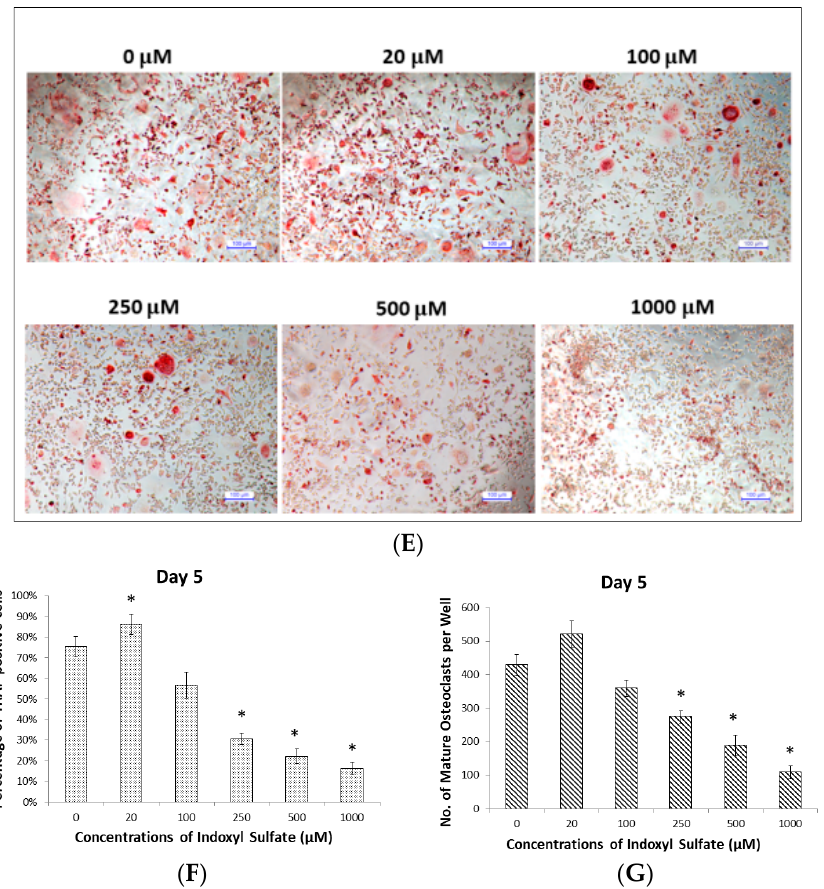
Figure 1. Dose- and time-dependent effects of indoxyl sulfate (IS) on osteoclast differentiation. Raw 264.7 cells with 50 ng/mL of sRANKL were cultured in IS at 0, 20, 100, 250, 500, and 1000 µM for 3 and 5 days. ( A ) The CCK-8 assay shows that cell viabilities are not significantly affected by low or high concentrations of IS on Days 3 or 5. Error bars represent mean ± SD ( n = 8). ( B ) Representative images of TRAP stained cells on Day 3 after treatment with different concentrations of IS; TRAP-positive stained cells with one nucleus are recognizable as osteoclast precursor cells (undifferentiated osteoclast cells). ( C ) The average percentage of TRAP-positive cells in each group on Day 3; the highest percentage was at 100 µM IS. Error bars represent mean ± SD ( n = 6). * P < 0.05 compared to the control group. ( D ) The average numbers of mature osteoclast cells (TRAP-positive stained cells with more than three nuclei) in each group on Day 3; the highest number was at 100 µM IS. Error bars represent mean ± SD ( n = 6). * P < 0.05 compared to the control group. ( E ) Representative images of TRAP stained cells on Day 5 after treatment with different concentrations of IS; TRAP-positive stained with more than three nuclei and recognizable as mature osteoclast cells. ( F ) The average percentage of TRAP-positive cells in each group on Day 5; the highest percentage was at 20 µM IS. Error bars represent mean ± SD ( n = 6). * P < 0.05 compared to the control group. ( G ) The average numbers of mature osteoclast cells in each group on Day 5; the highest number was at 20 µM IS. Error bars represent mean ± SD ( n = 6). * P < 0.05 compared to the control group.